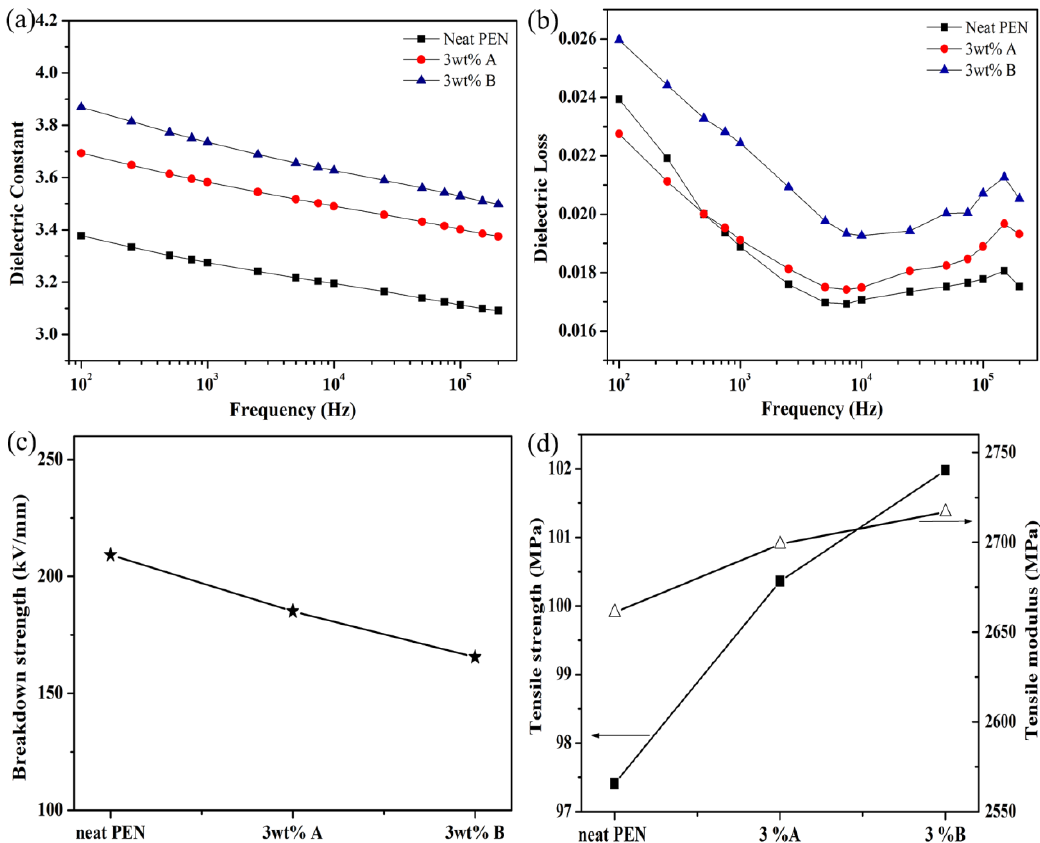
Figure 8. The ( a ) dielectric constant, ( b ) dielectric loss, ( c ) breakdown strength, and ( d ) mechanical property of neat H -PEN film, A: O -Fe 3 O 4 /FePc/ H -PEN and B: E -Fe 3 O 4 /FePc/ H -PEN.